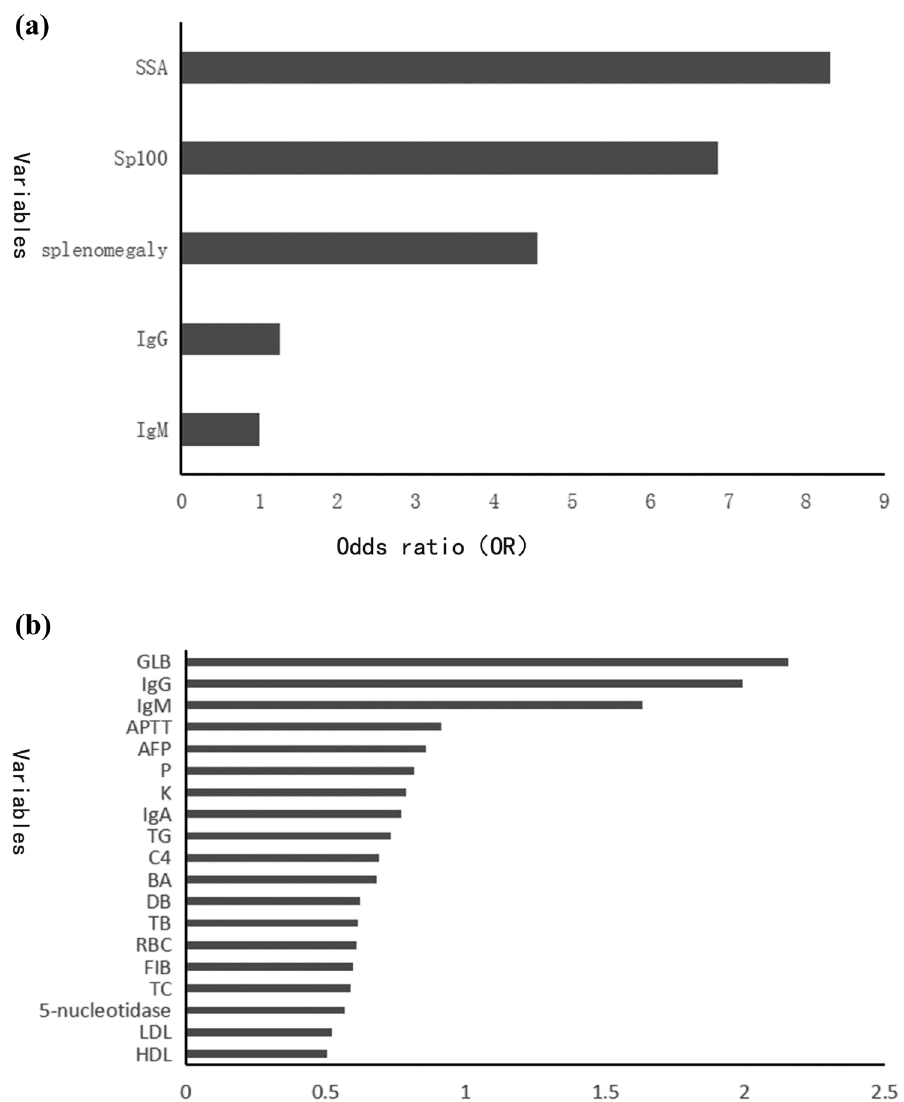
Figure 2: The importance ranking of variables predicting the diagnosis of PBC and OS. ( a ) OS - related variables ranked by logistic regression analysis ( P ＜ 0.05 ) . ( b ) OS - related variables ranked by random forest analysis. SSA, anti - SSA antibody; Sp100, anti - Sp100 antibody; P, serum phosphorus level; K, serum potassium level; TG, triglyceride; C4, complement 4; BA, serum bile acid; DB, direct bilirubin; TB, total bilirubin; FIB, fi brin; TC, total cholesterol; LDL, low - density lipoprotein; HDL, high - density